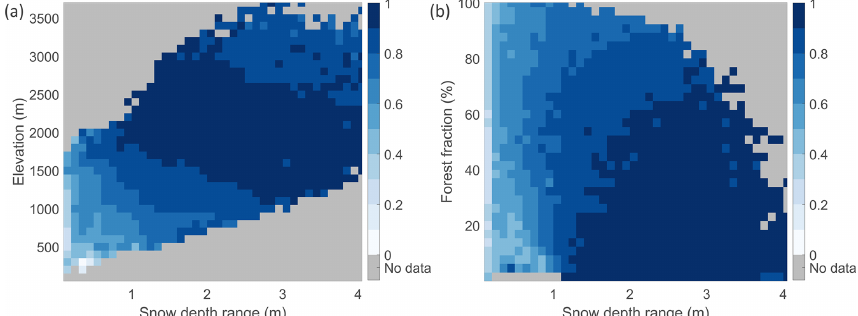
Figure 8. The time series correlation between simulated and retrieved snow depth (m) at 1km resolution, stratified by (a) elevation (m) and snow depth range (m) and (b) forest cover fraction (%) and snow depth range